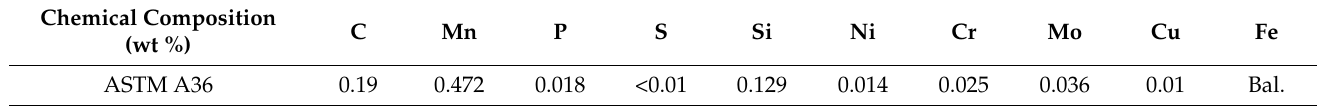
Table 1. Chemical composition ASTM A36.